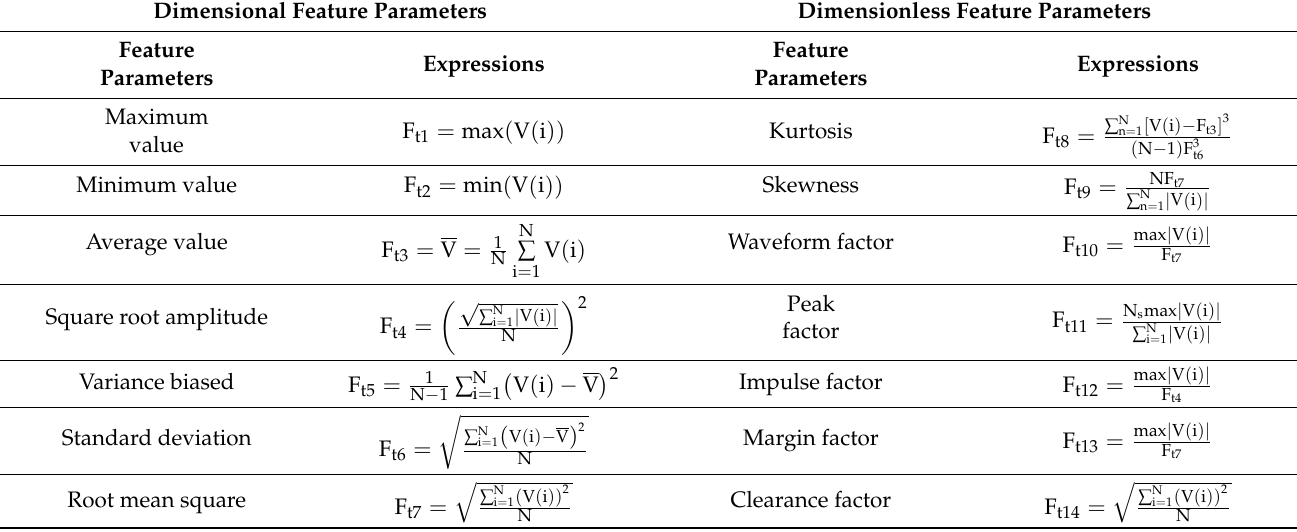
Table 3. Time domain feature parameters and their expressions.